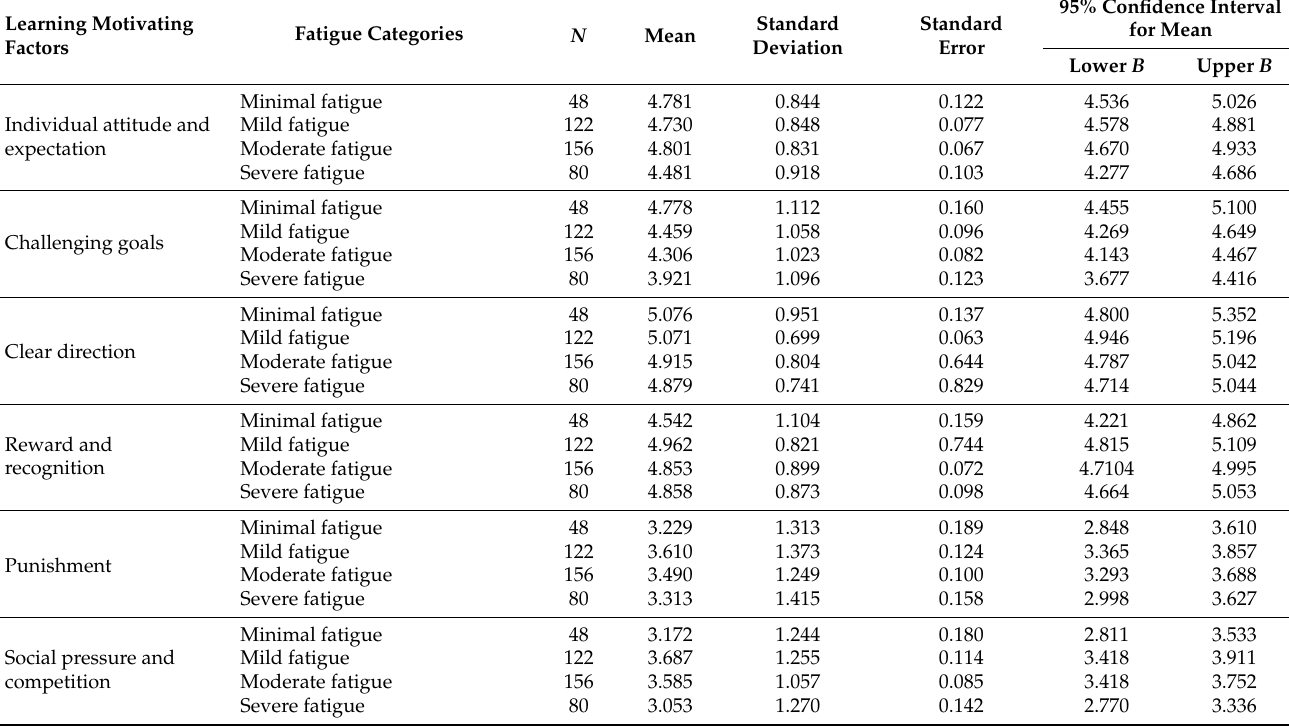
Table 10. Differences in learning motivating factors based on the MFI-20